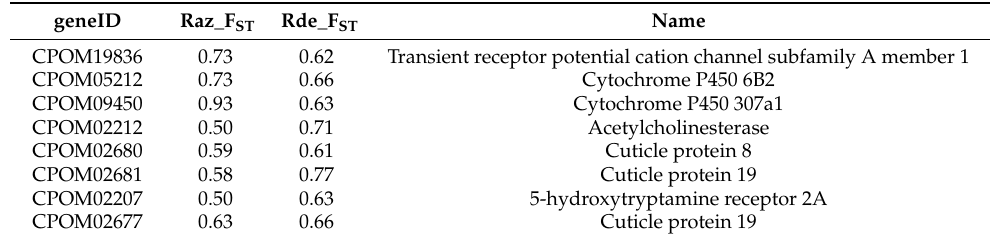
Table 1. F ST values of eight resistance-related genes showing strong selective signature in both Raz and Rde strains of C. pomonella, respectively. Maximum F ST value is